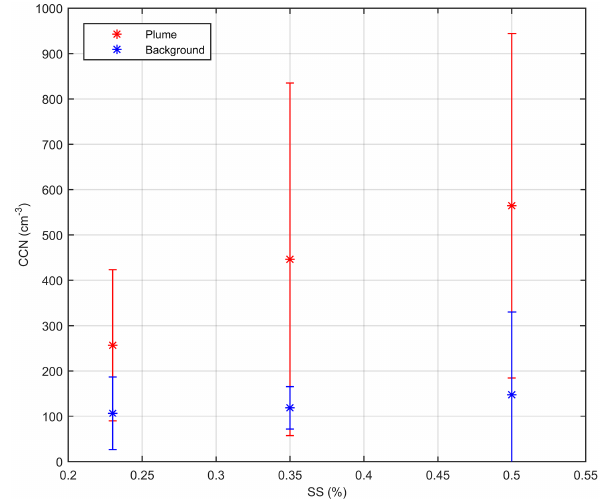
Figure 5. CCN concentrations as function of supersaturation. Mea- surements inside the plume are shown in red, while background conditions are represented in